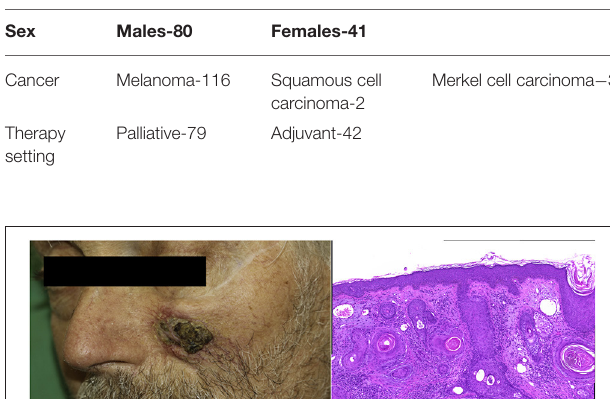
TABLE 1 | Distribution of sex, cancer type, and therapy setting of all patients.